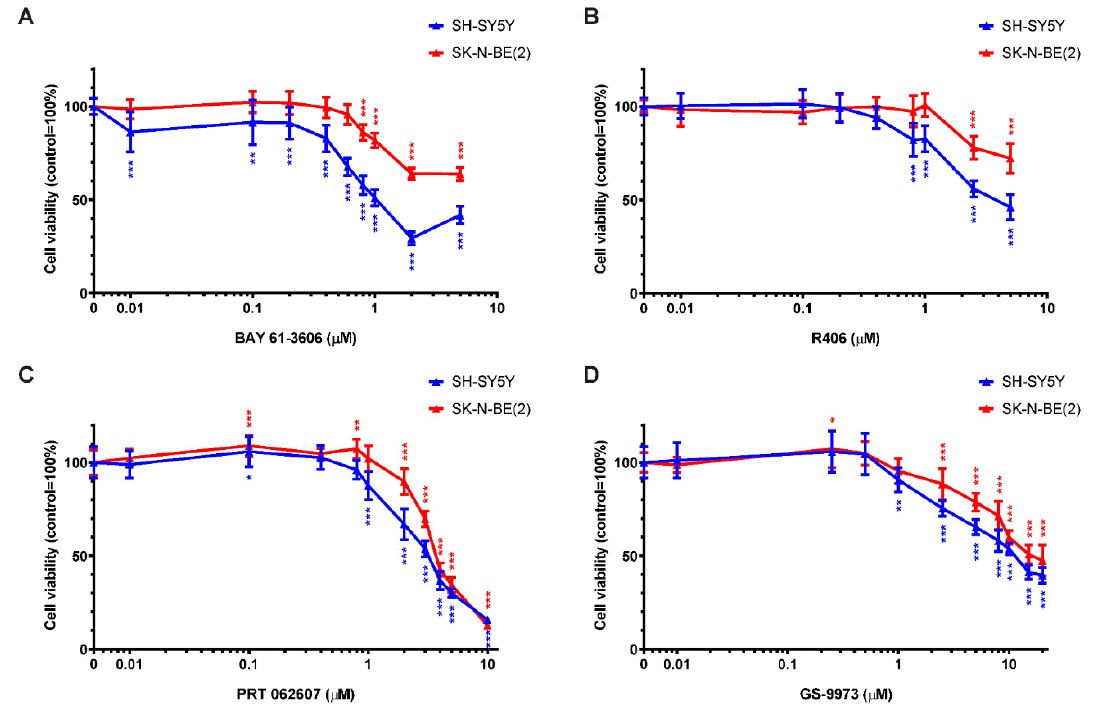
Figure 5. Inhibition of SYK decreases the cell viability of neuroblastoma cells. Cell viability was measured in SH-SY5Y and SK-N-BE(2) cells by MTT assay after 48 h incubation with increasing concentrations of the SYK inhibitors BAY 61-3606 ( A ) R406 ( B ) PRT062607 ( C ) GS-9973 ( D ). The control was set as 100% viable cells. Data are presented as mean ± SD from three independent experiments. Using two-way ANOVA, a significant difference between cell lines and a significant effect of the inhibitor p < 0.001 was seen. Dunnett’s multiple comparison test was used to evaluate the difference between vehicle treated control cells and the various inhibitor concentrations: * p < 0.05 ** p < 0.01 *** p < 0.001.